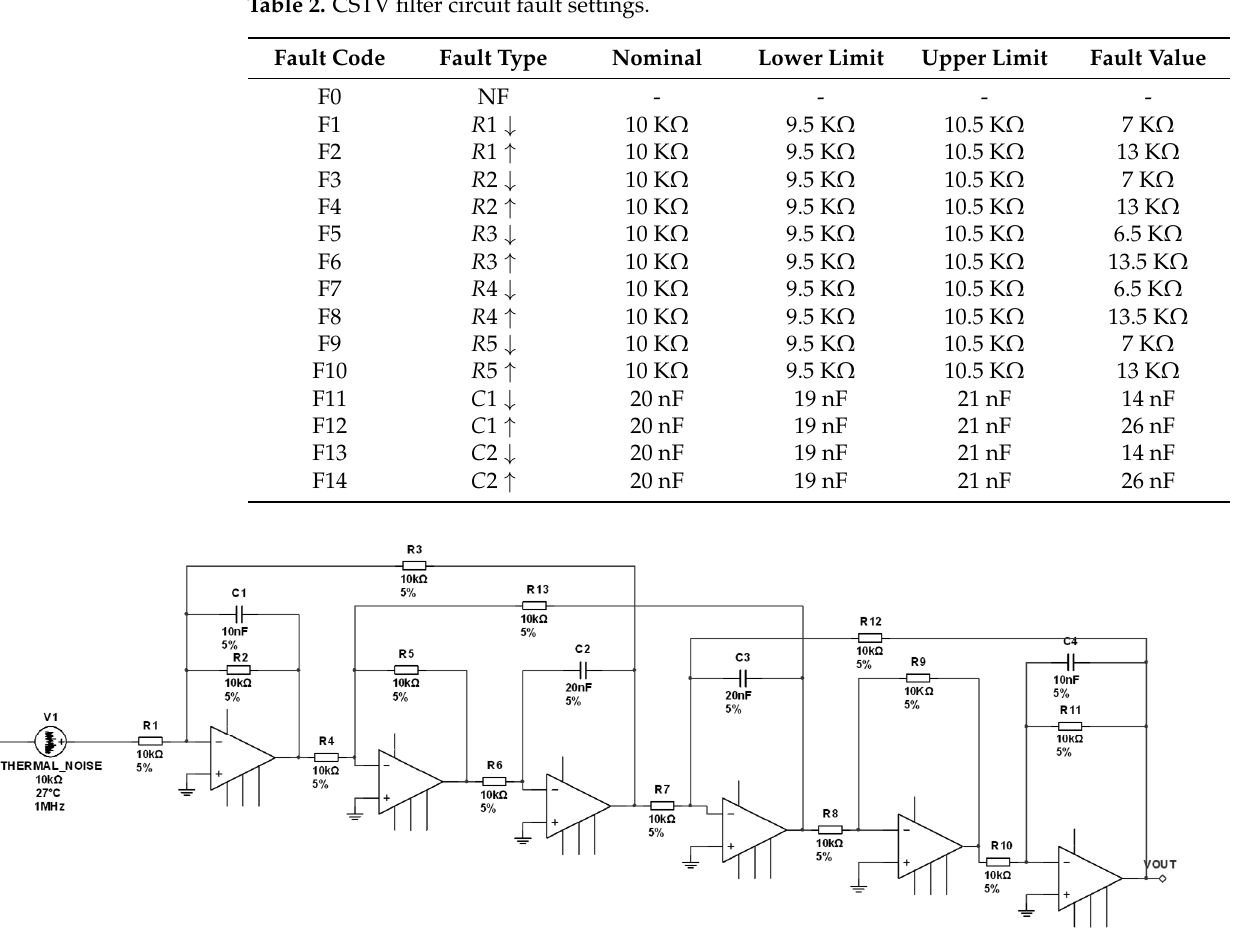
Figure 8. Leap-frog low-pass filter circuit. Table 3. Leap-frog low-pass filter circuit fault settings.